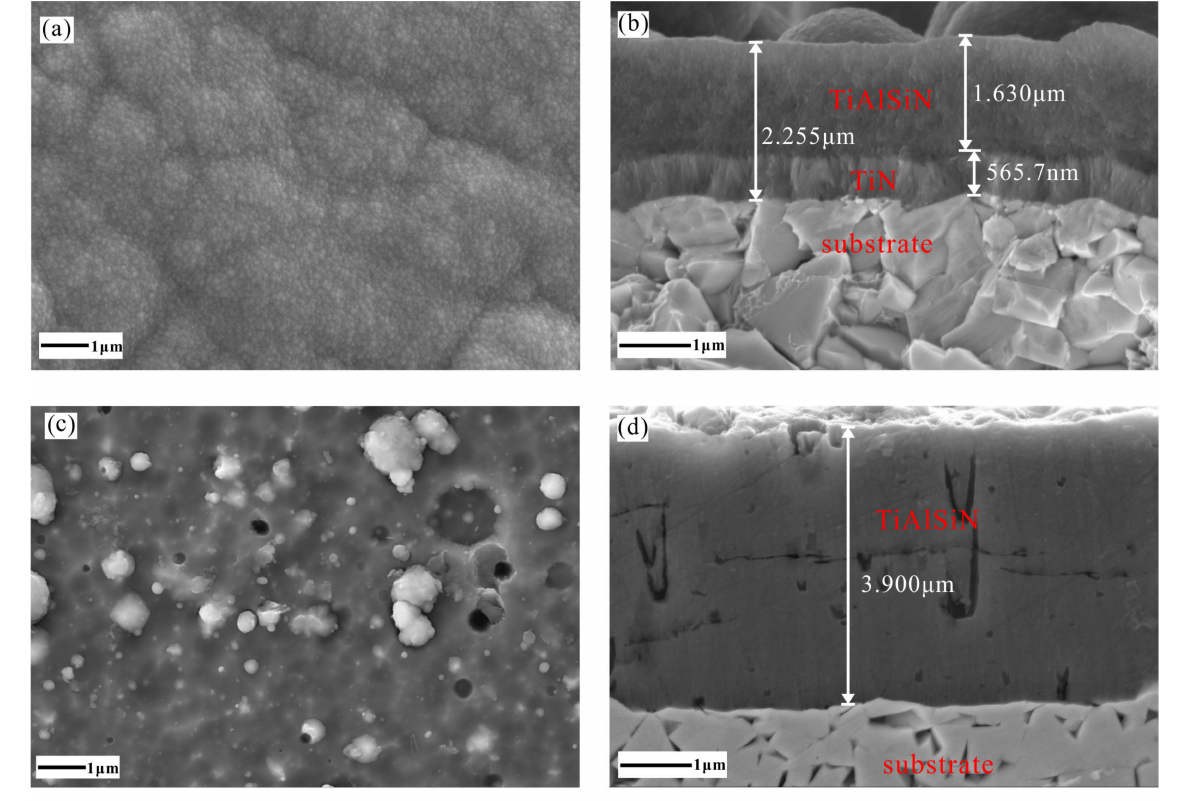
Figure 2. FESEM micrographs of two different coatings: ( a ) CVD Ti 0.13 Al 0.85 Si 0.02 N, surface; ( b ) CVD Ti 0.13 Al 0.85 Si 0.02 N, cross-section; ( c ) PVD Ti 0.31 Al 0.60 Si 0.09 N, surface; ( d ) PVD Ti 0.31 Al 0.60 Si 0.09 N,